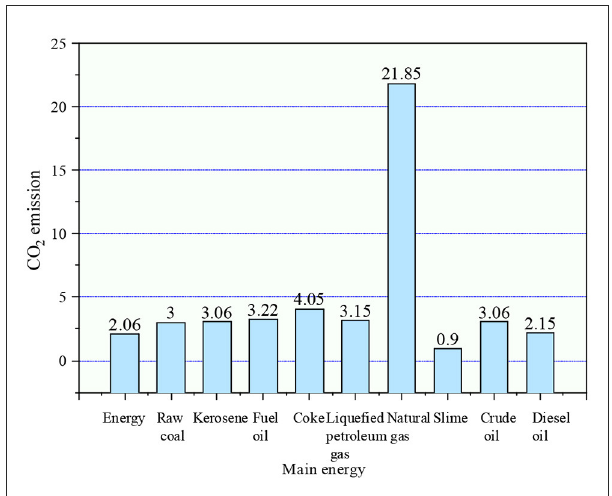
FIGURE4 The emission coefficient of the primary energy CO 2 .